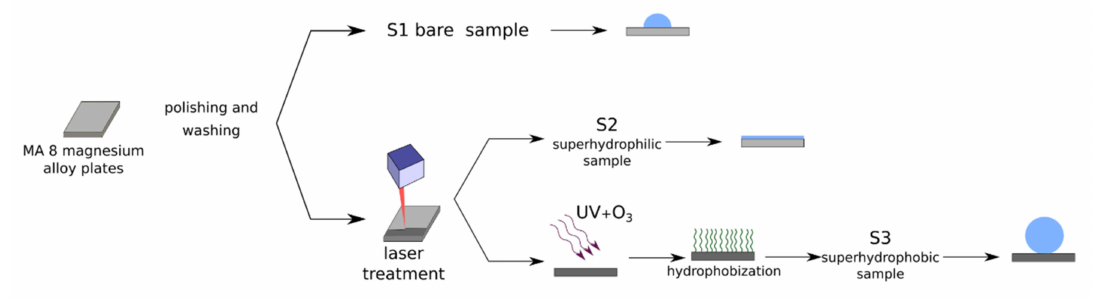
Figure 1. The fabrication procedure for the samples used in this